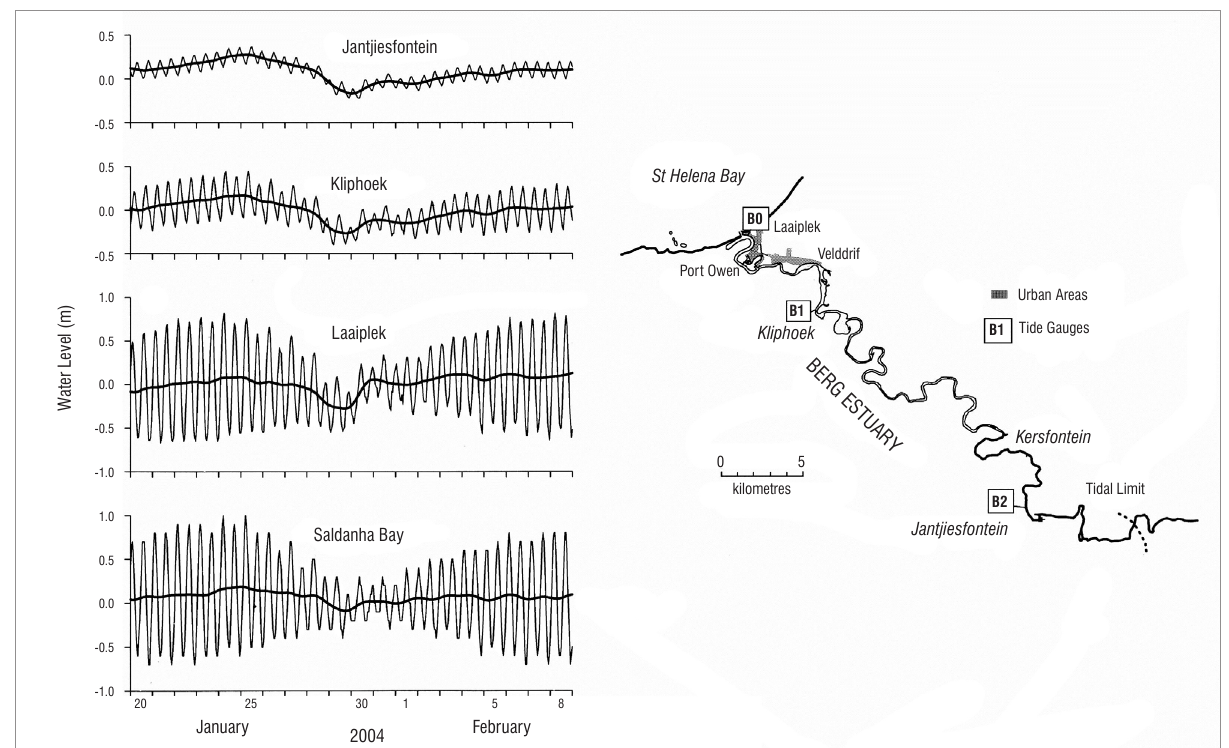
Figure 6: Water level variations during January and February 2004 at Saldanha Bay and at three sites within the Berg Estuary: B0 at Laaiplek, B1 at Kliphoek and B2 at